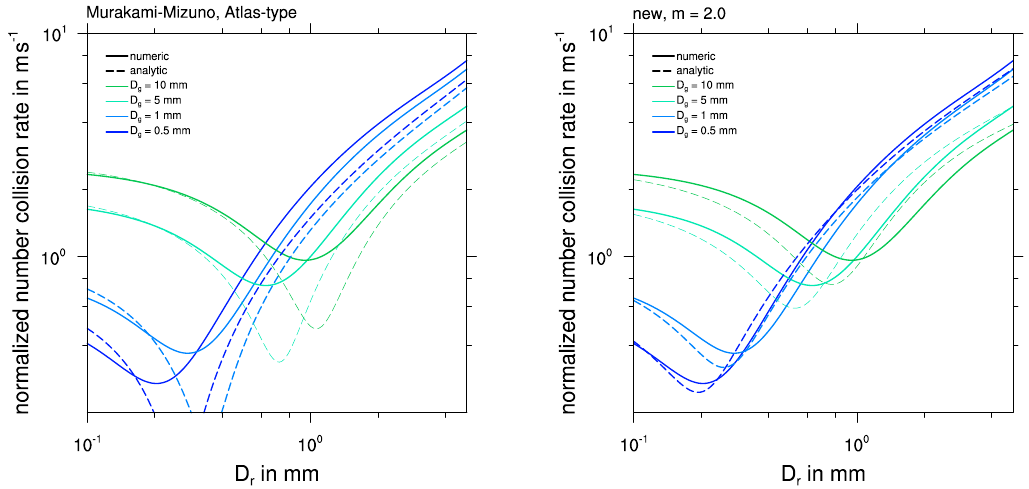
Fig. 5. As Fig. 4 but for the normalized number collision rate of graupel and Fig. 5. As Fig. 4, but for the normalized number collision rate of graupel and rain.